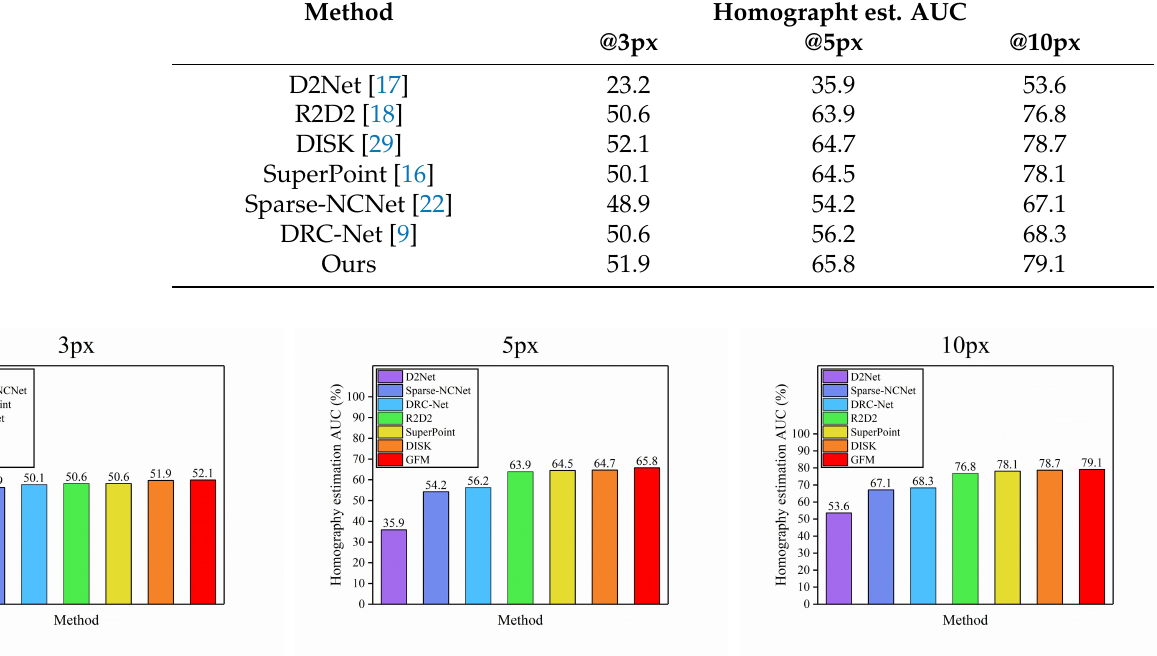
Figure 7. Homography estimation on Hpatches. The three graphs represent the AUC values of each method with a threshold of 3 px, 5 px, and 10 px. Different colored rectangles represent different baseline